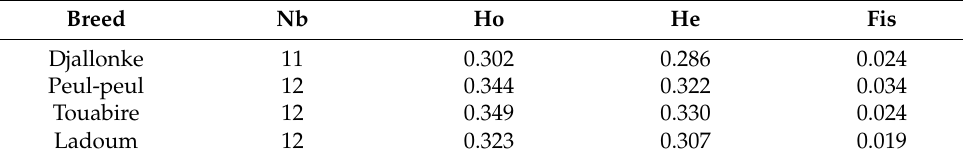
Table 2. Genetic diversity estimates in the four studied Senegalese sheep